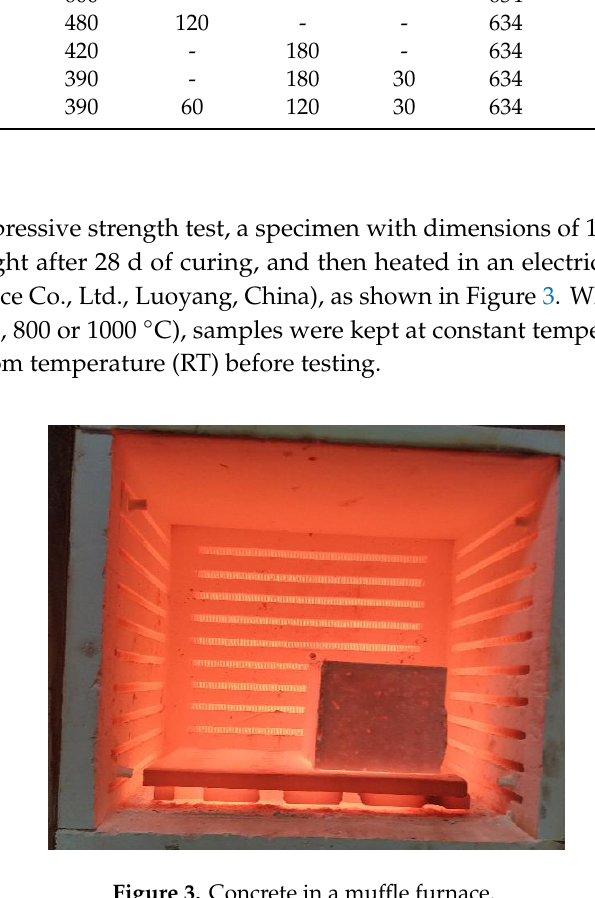
Figure 3. Concrete in a muffle furnace.